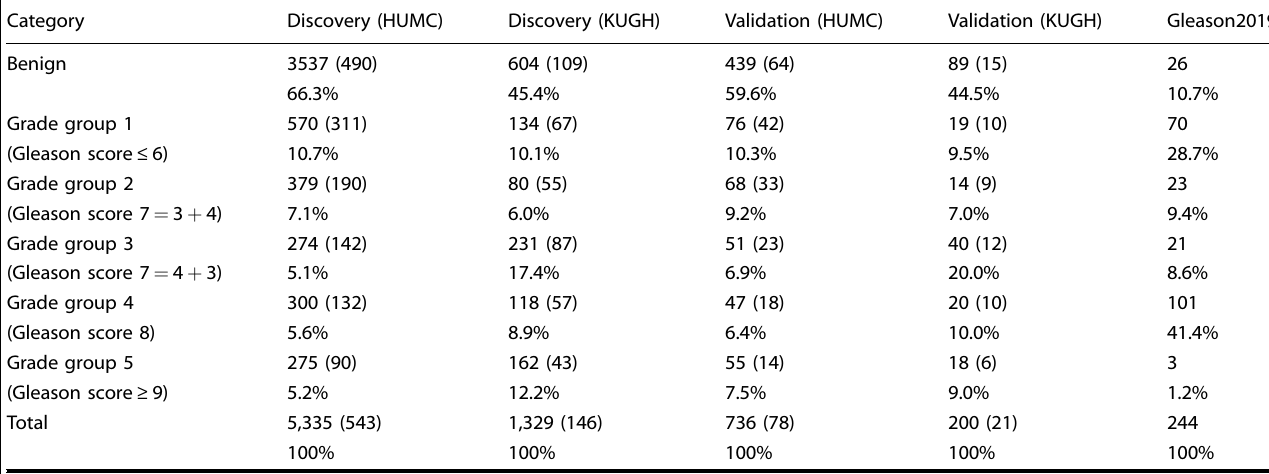
Table 1. Number of slides and cases in the entire dataset for this